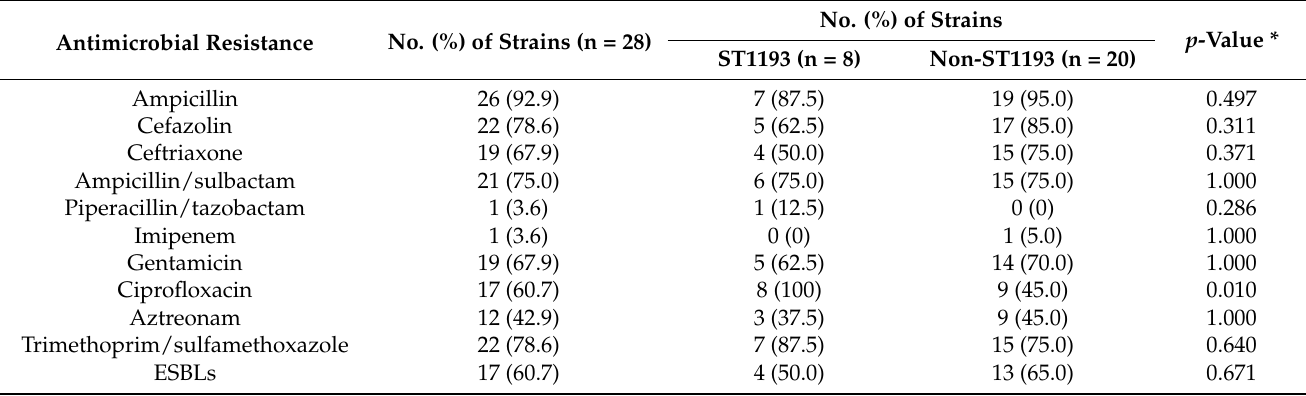
Table 2. Antimicrobial resistance of the 28 E. coli